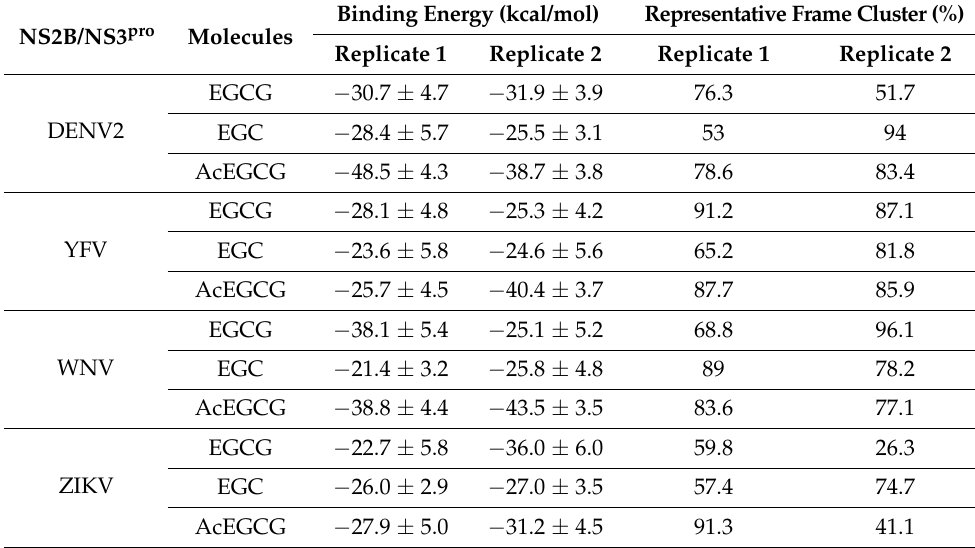
Table 8. Summary of the MD simulations of the NS2B/NS3 proteases in complex with the epigallo- catechin